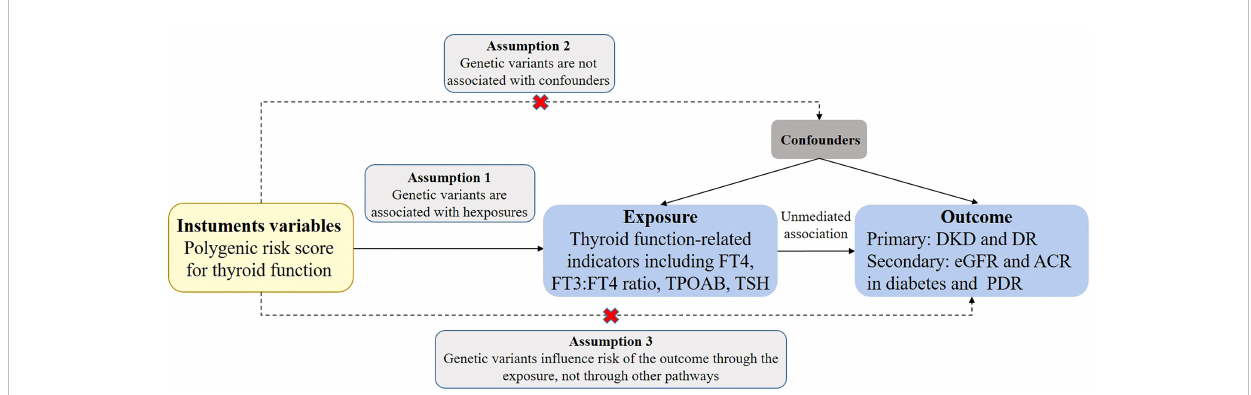
FIGURE 1 Assumptions of a Mendelian randomization analysis for thyroid function and risk of DKD and DR. Broken lines represent potential pleiotropic or direct causal effects between variables that would violate Mendelian randomization assumptions. FT4, free thyroxine; FT3, free triiodothyronine; TSH, thyroid-stimulating hormone; TPOAB, thyroid peroxidase antibodies; DKD, diabetic kidney disease; DR, diabetic retinopathy; PDR, proliferative diabetic retinopathy; eGFR, estimated glomerular fi ltration rate; ACR, urinary albumin-to-creatinine